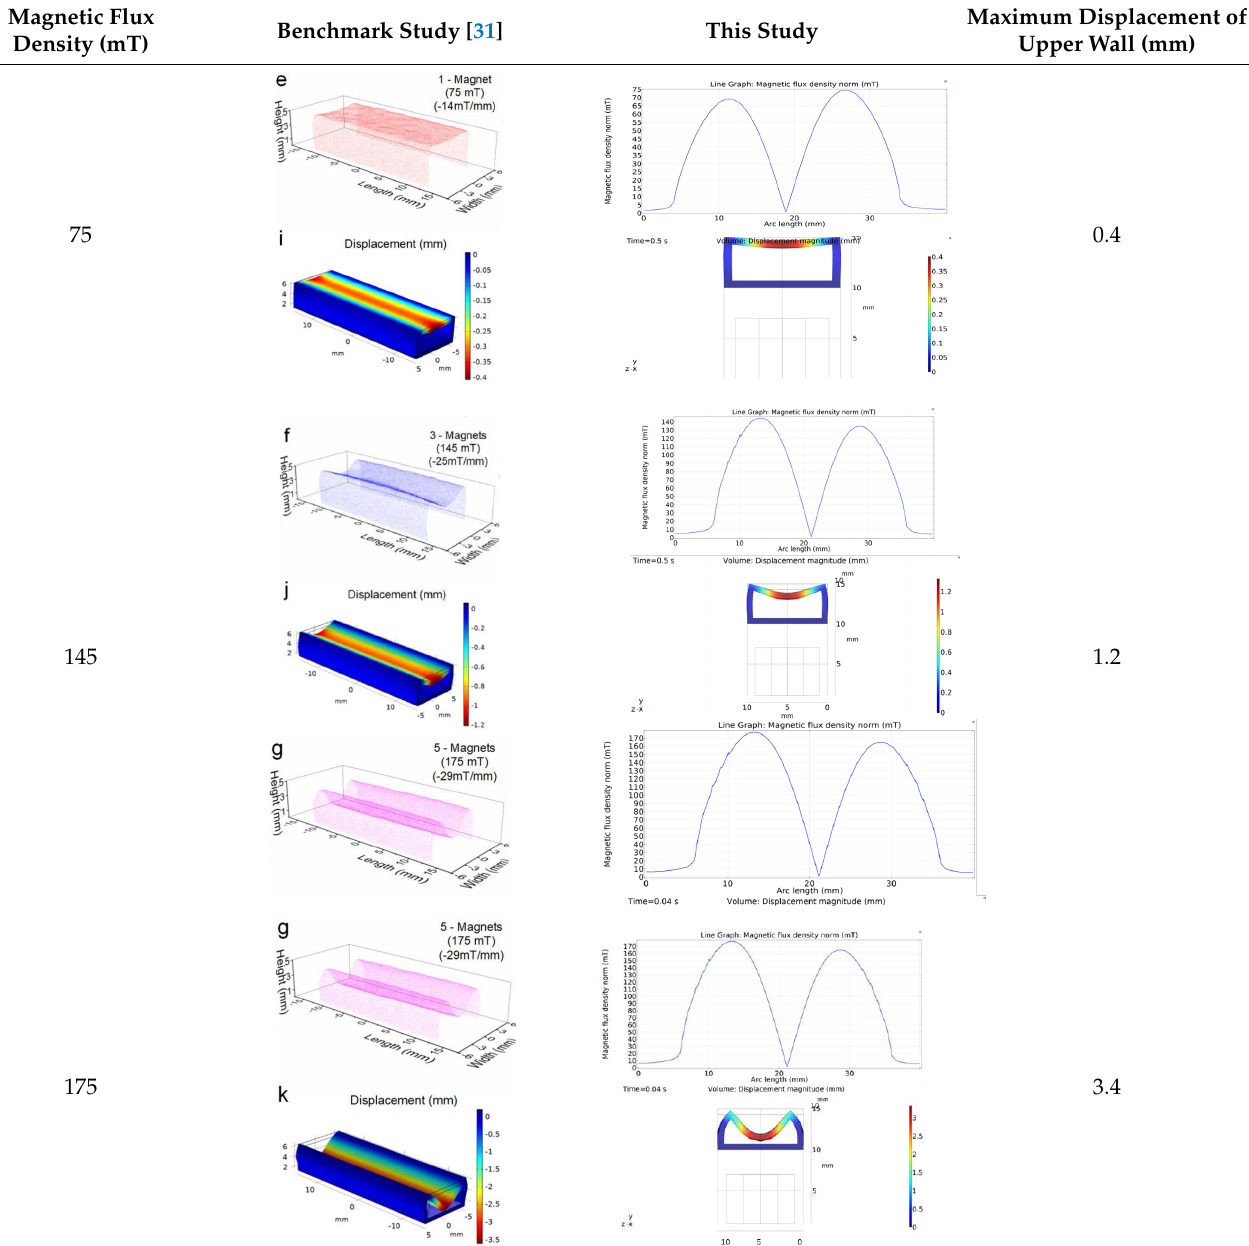
Table 3. Comparisons of simulations between this study and benchmark study.